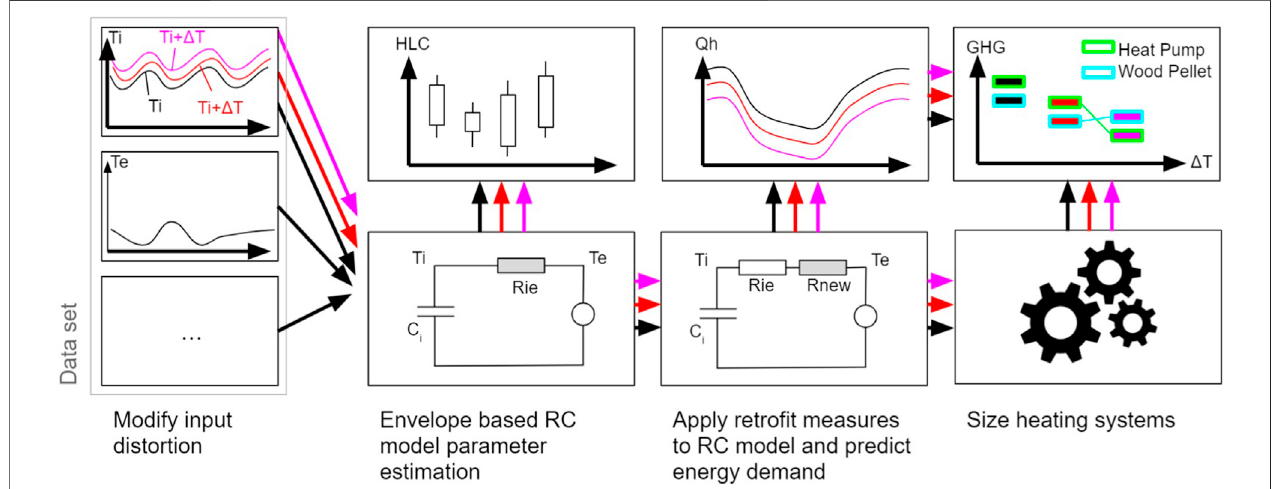
FIGURE 2 | Process diagram of calculating the propagation of sensor measurement uncertainty error on the impact assessment of retro fi ts. The red and magenta lines represent the synthetically distorted measurement data.